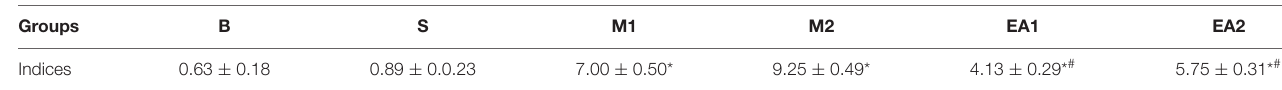
TABLE 4 | Rabbit cartilage histology Mankin Grading Standard.